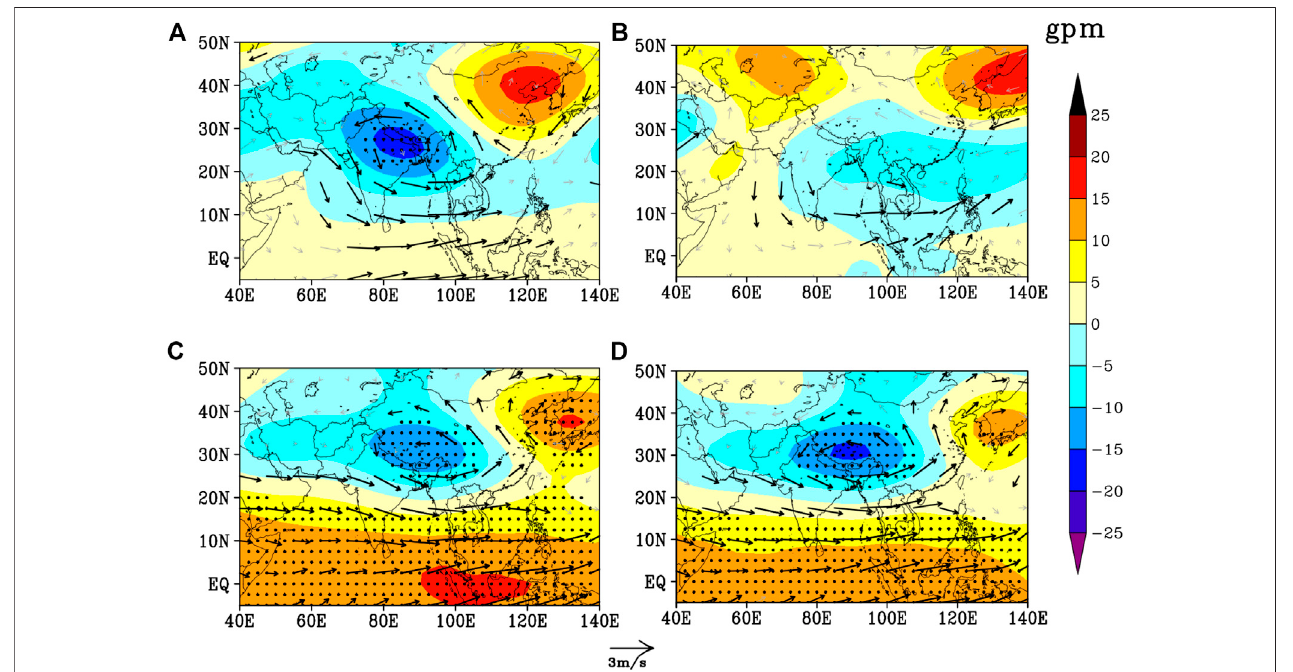
FIGURE 9 | Regression maps of the AM-mean wind anomaly (vectors; unit: m/s) and geopotential height anomaly (shaded; unit: m) at 150 hPa against the (left) BOBSM onset time and (right) SCSSM onset for (upper) 1958 – 1979 and (bottom) 1980 – 2018. The stippling and black vectors denote values exceeding the 90% con fi dence level.